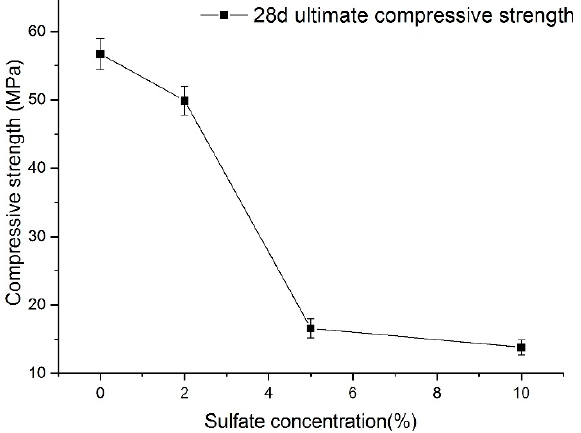
Figure 13. Relationship between sulfate concentration and the final strength of samples. 324